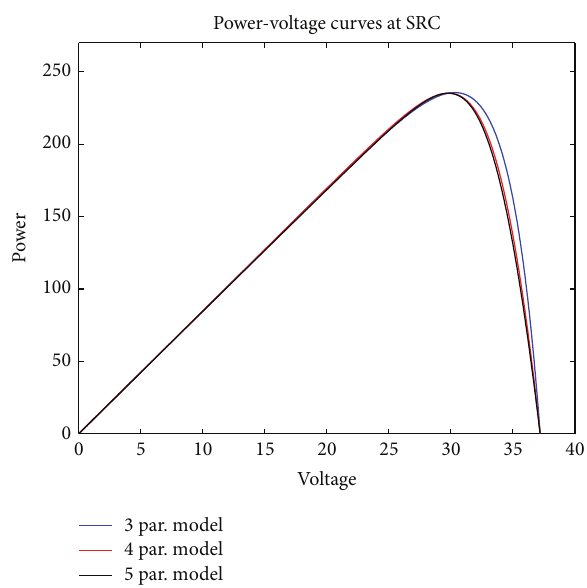
Figure 8: Power-Voltage curves at SRC of BP 3 235T, traced by using 3/4/5 parameter